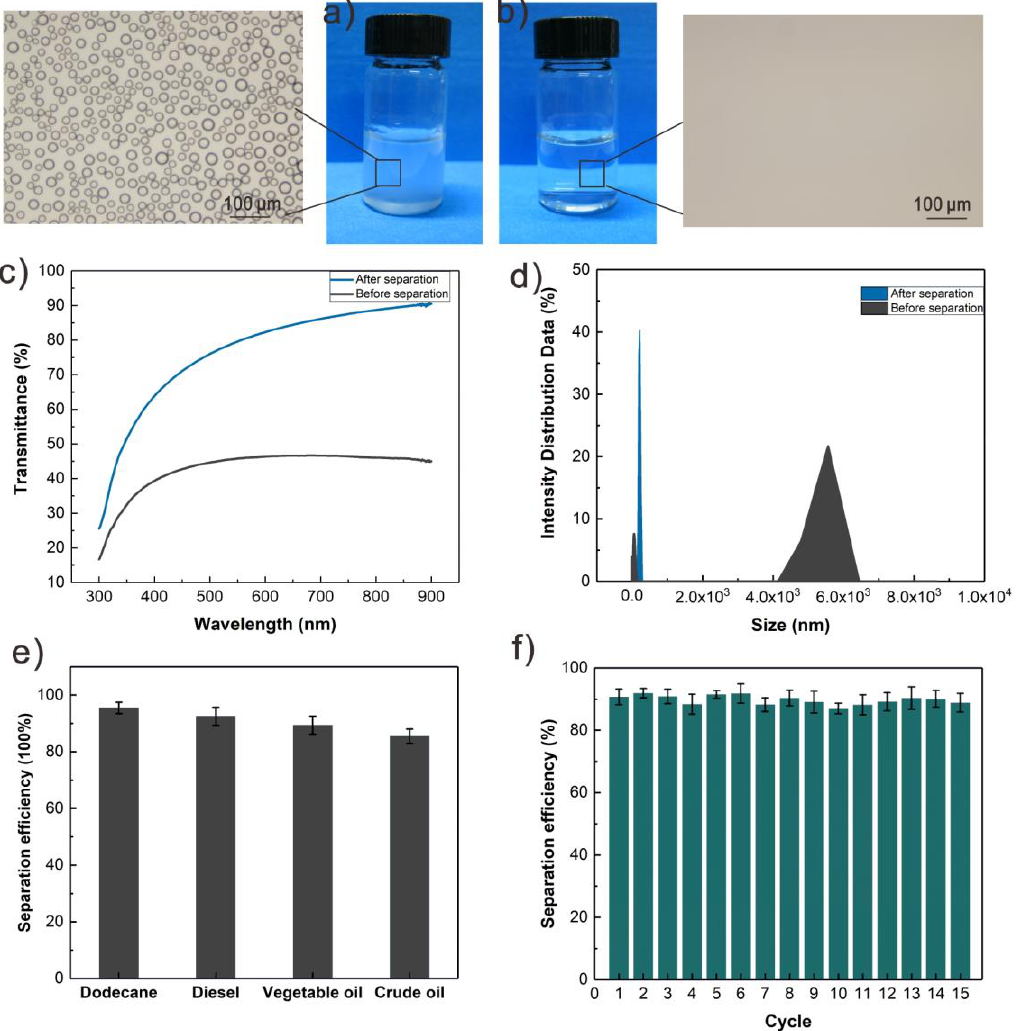
Figure 5. Oil-in-water emulsion separation results. Optical microscopy images of oil-in-water emulsion, ( a ) before and ( b ) after filtration. ( c , d ) The ultraviolet transmittance and emulsion size before and after filtration. ( e ) The separation e ffi ciency of dodecane, diesel, vegetable oil, and crude oil. ( f ) Cycle separation test of 15 times of dodecane-in-water